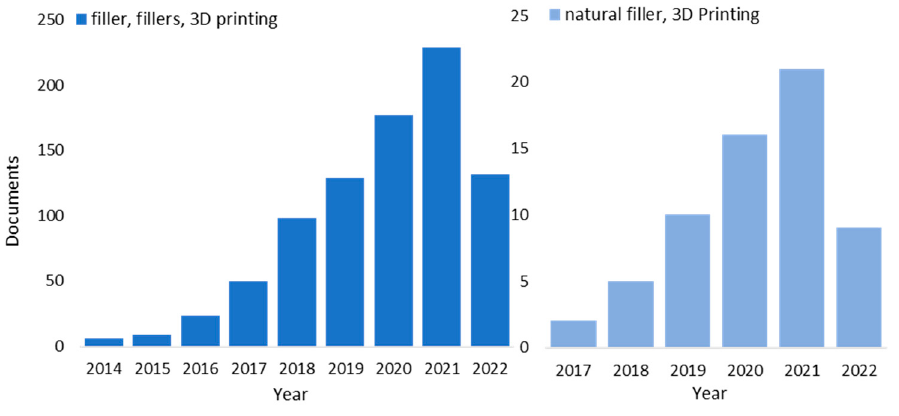
Figure 5. Scopus key words: filler, fillers, 3D printing; natural filler, 3D printing.